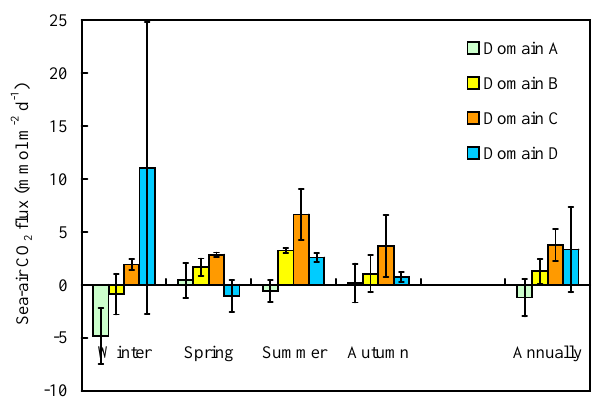
Fig. 8. Sea–air CO 2 flux estimation in four physical– biogeochemical domains in the South China Sea proper. Note that we used satellite-derived monthly averaged wind speeds and the Sweeney et al. (2007) equation (Eq. 1) to calculate gas transfer velocities and then sea–air CO 2 fluxes. Also shown are the “error” bars associated with each flux estimates, which were mostly attributable to intraseasonal variability. See text for